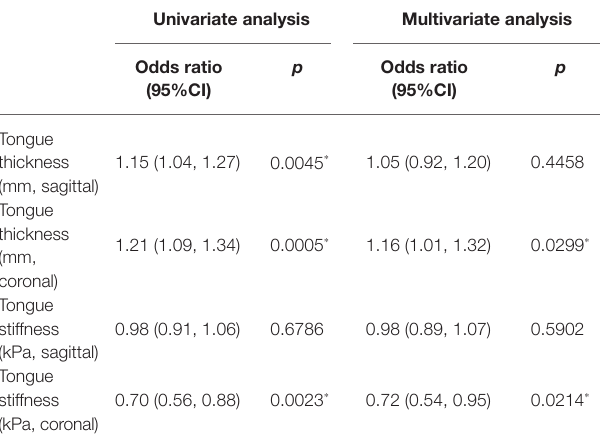
TABLE 4 | Receiver operating characteristic curve analysis for the best cut-off points as regards ultrasound measurements for differentiating patients with obstructive sleep